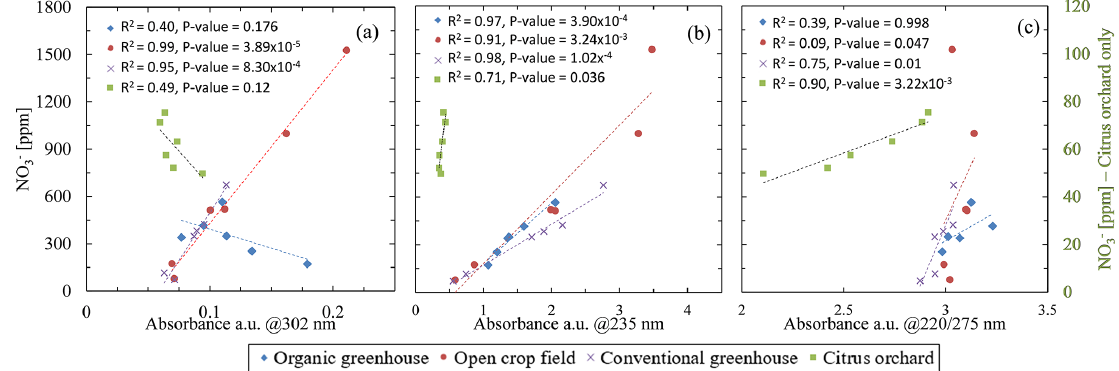
Figure 3. Nitrate concentration vs. absorbance at various wavelengths. Right ordinate presents nitrate concentration for the citrus orchard